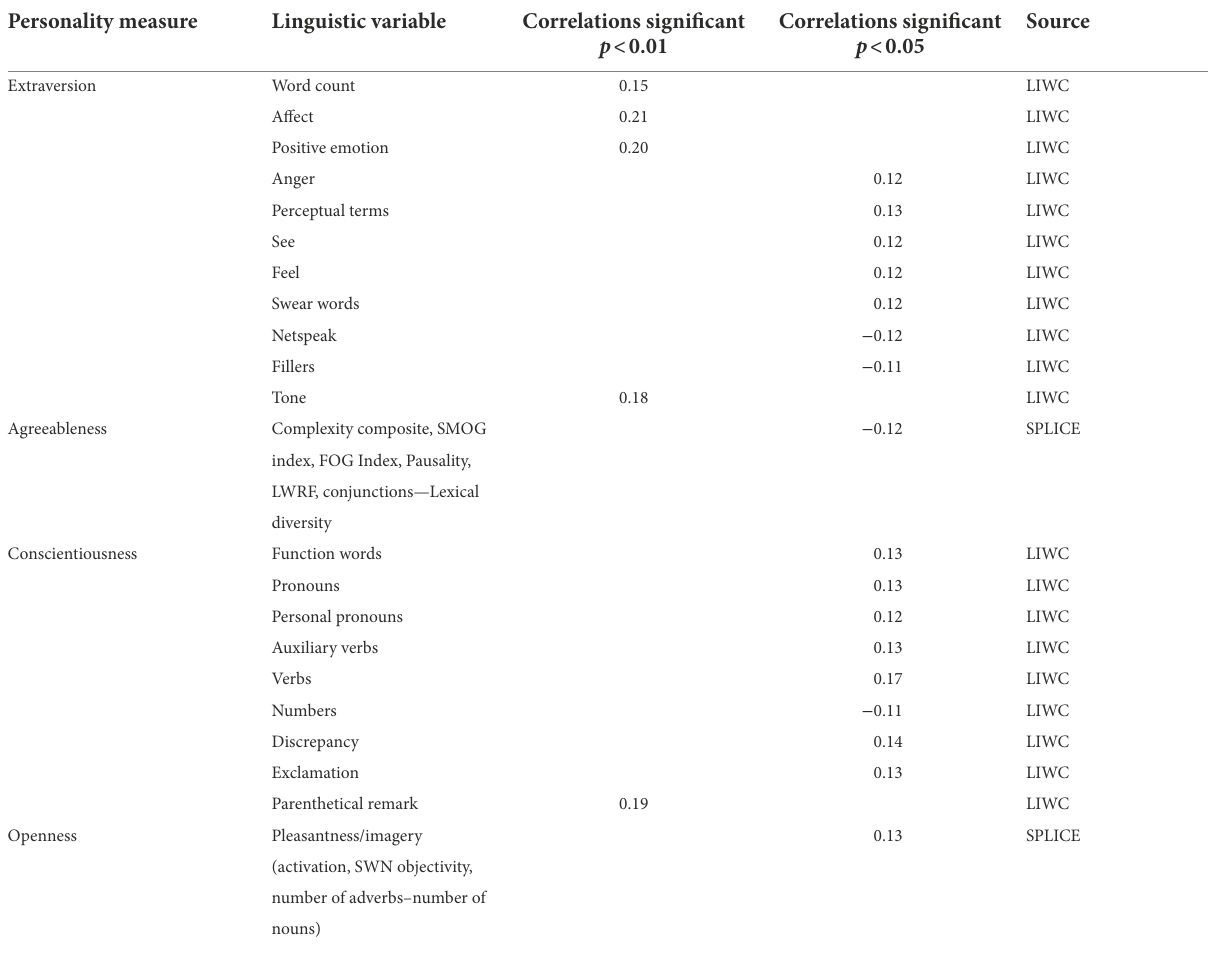
TABLE 6 Language variables with significant correlations with personality dimensions. Personality